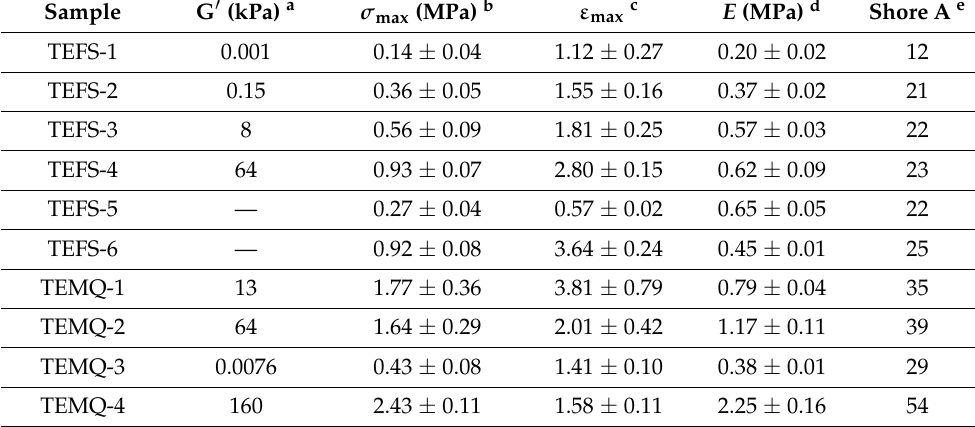
Table 2. Summary of mechanical properties determined by tensile elongation, durometry, and rheol- ogy. a G (cid:48) is the shear modulus of the uncured resin determined by rheology. b σ max engineering stress is the ultimate tensile strength determined by ASTM D638 testing. c ε max (mm/mm) engineering strain is the elongation at break. d E is the Young’s modulus determined at 0.2% engineering strain.